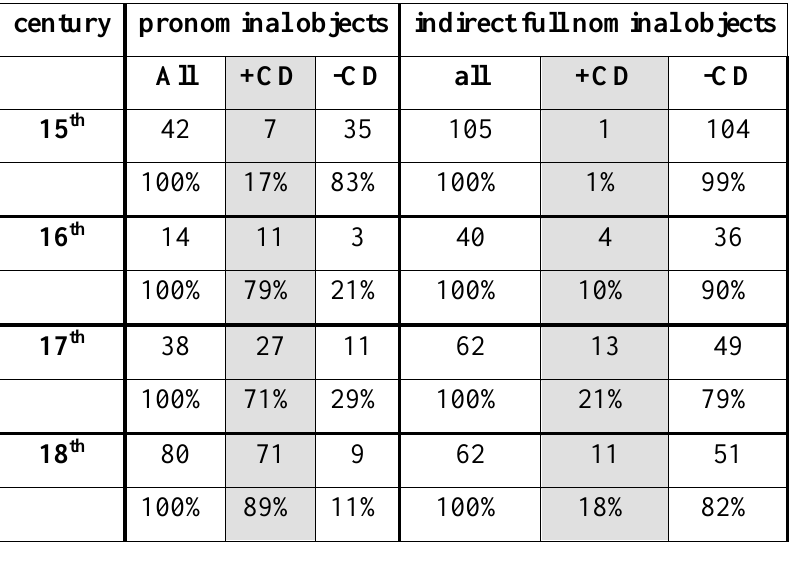
Table 1 : Distribution of strong pronominal (direct and indirect) objects, indirect full nominal objects and experiencer arguments with and without a clitic (15 th - 18 th centuries), apud Gabriel and Rinke (2010)